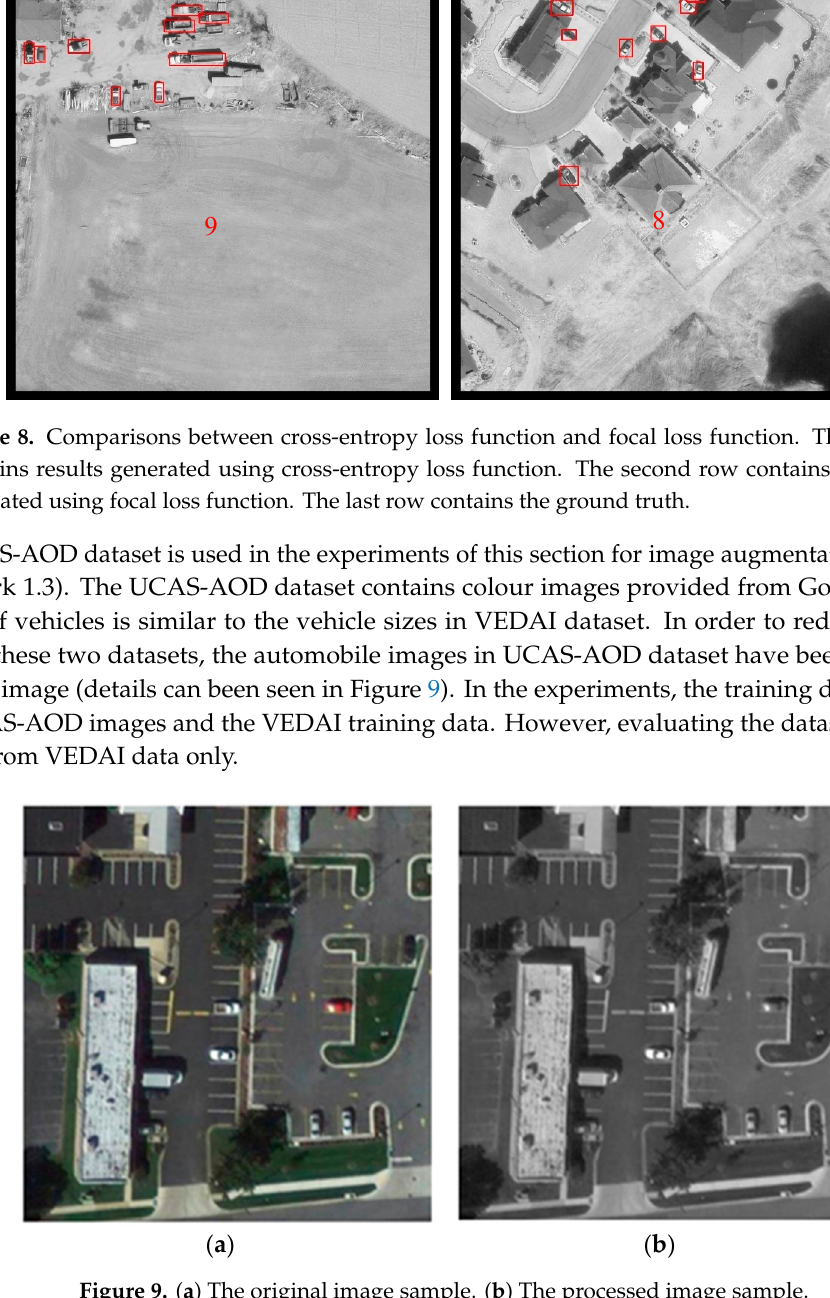
Figure 9. ( a ) The original image sample. ( b ) The processed image sample.